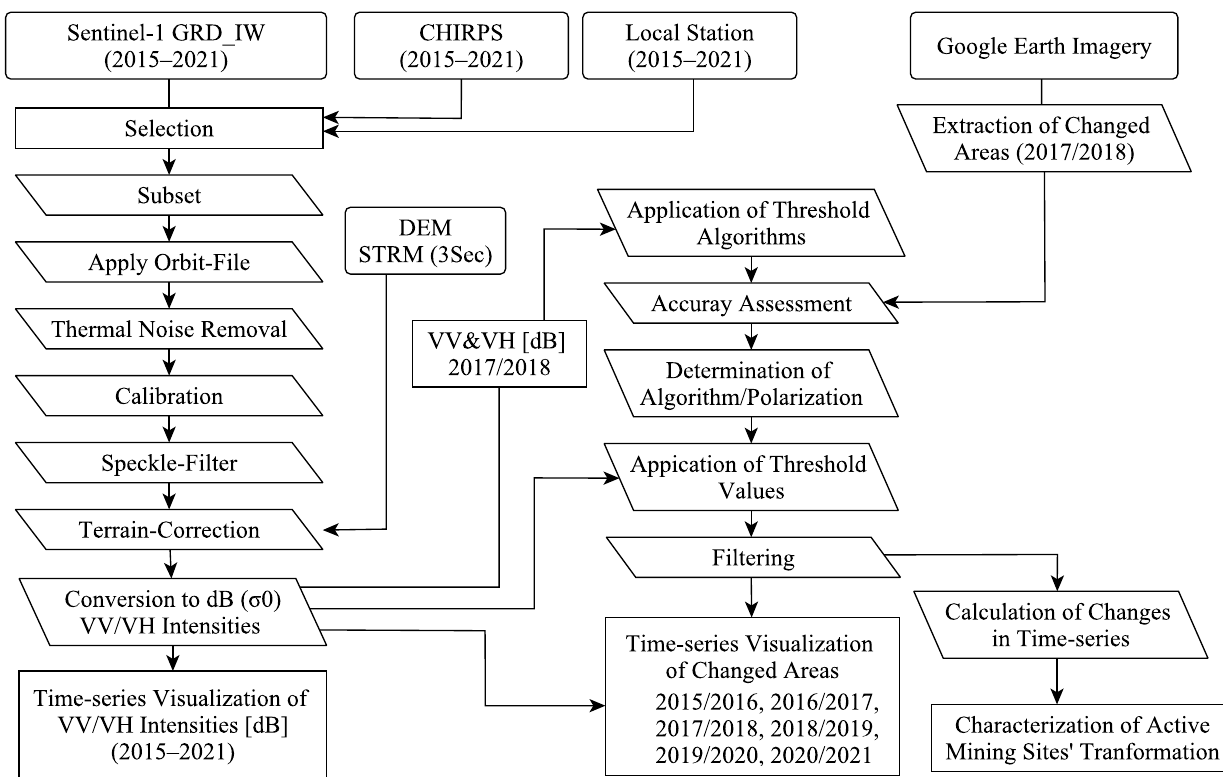
Figure 1. Overall